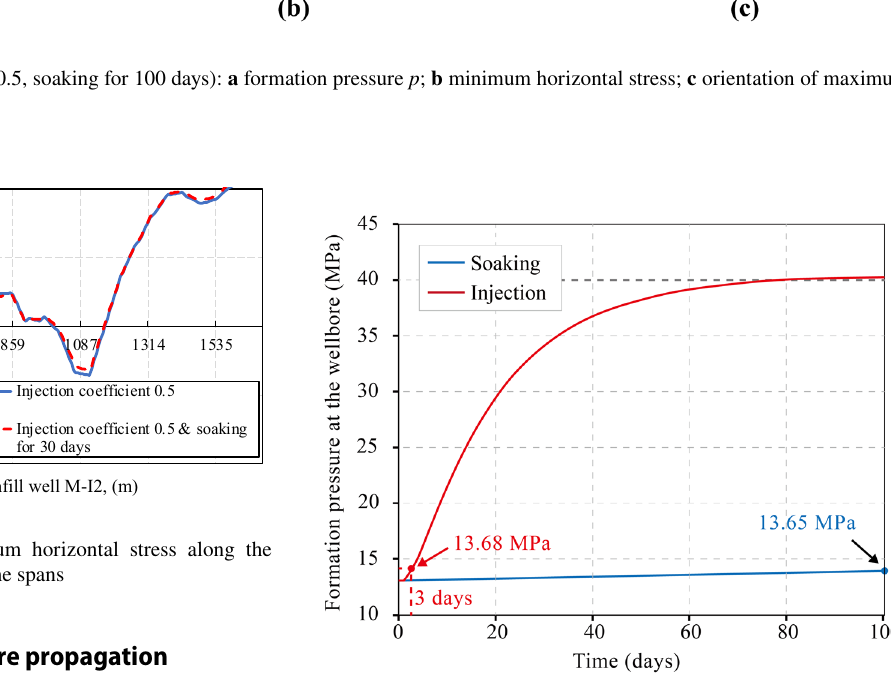
Fig.15 Comparison between the influences of injection and of soak- ing on the wellbore